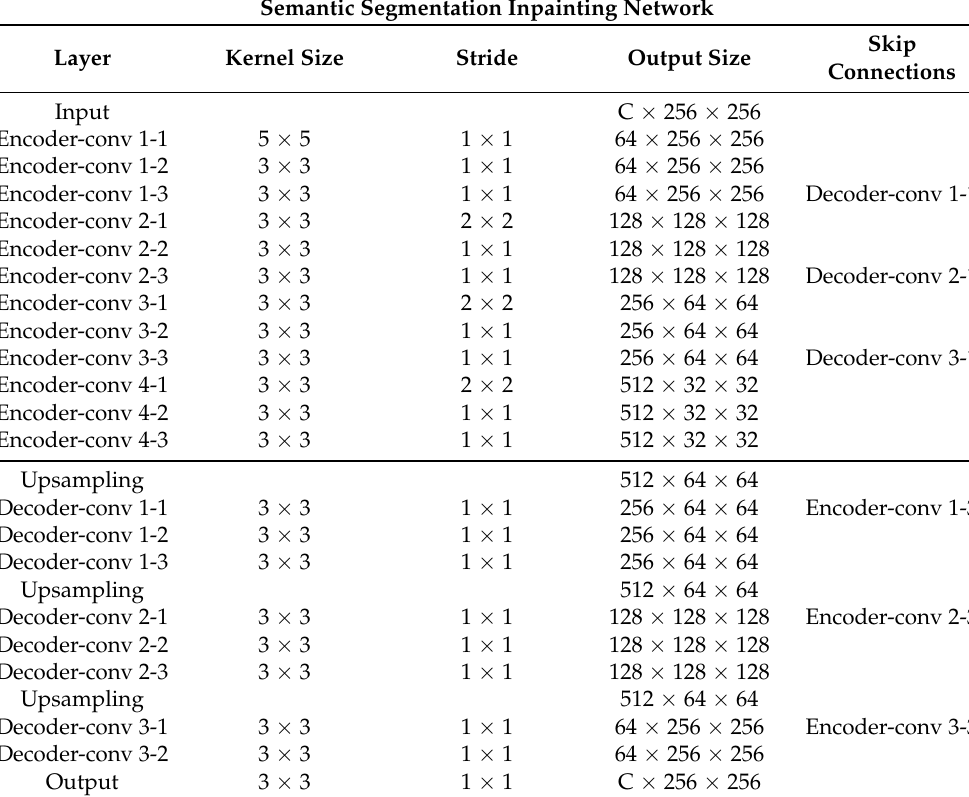
Table 1. Semantic segmentation inpainting network architecture